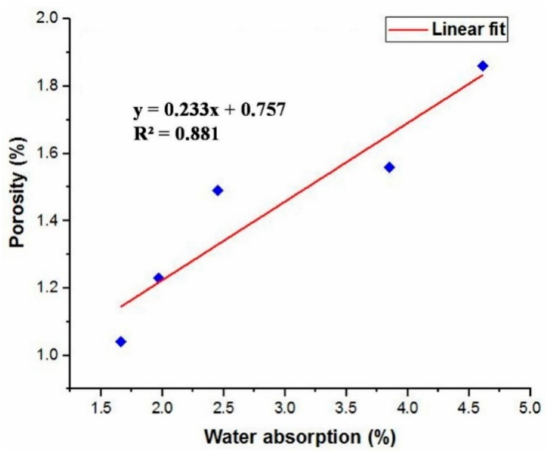
Figure 18. Relation between water absorption and porosity of the concrete